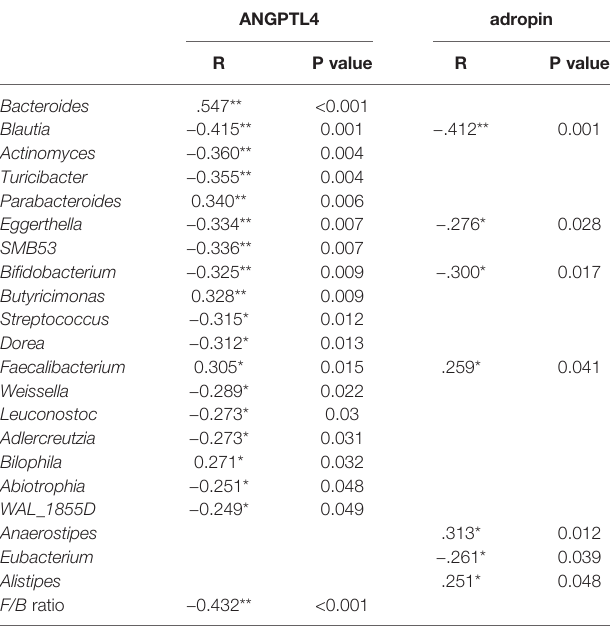
TABLE 3 | Spearman ’ s correlation table on OTUs and cytokine.